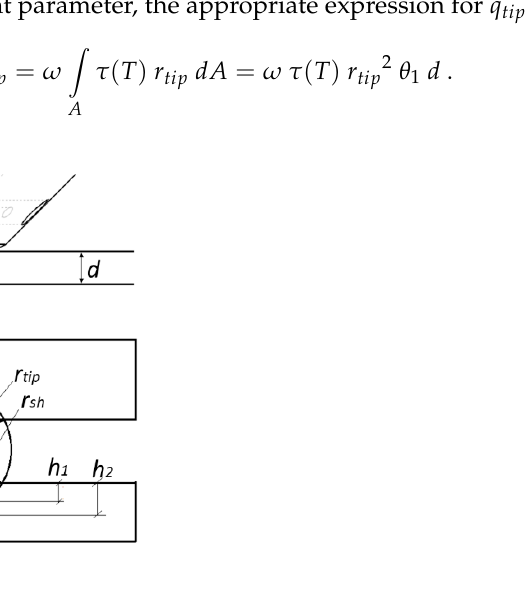
Figure 4. Schematic drawings defining the contact conditions during butt welding of aluminium plates using the HYB PinPoint extruder; ( a ) “Pin-in-groove” situation, ( b ) “Bird-eye” view of the rotating pin inside the groove.